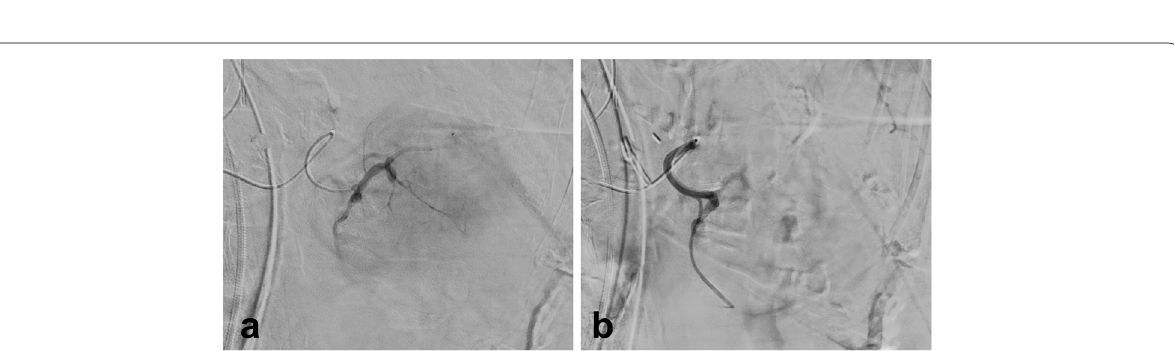
Fig. 3 a Selective angiography of tumor‑feeding vessel showed the hypervascular lesion with a tumor blush. b Angiography of the